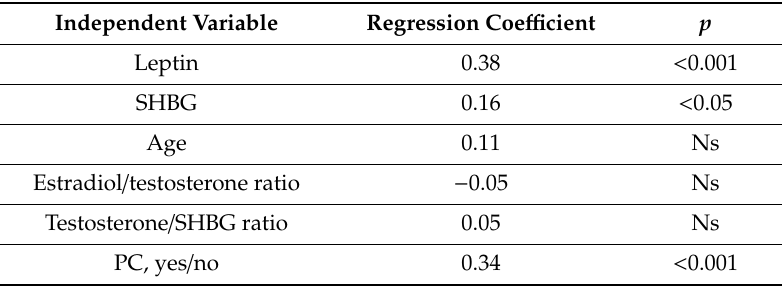
Table 4. Multiple regression analysis for serum omentin. Dependent variable: